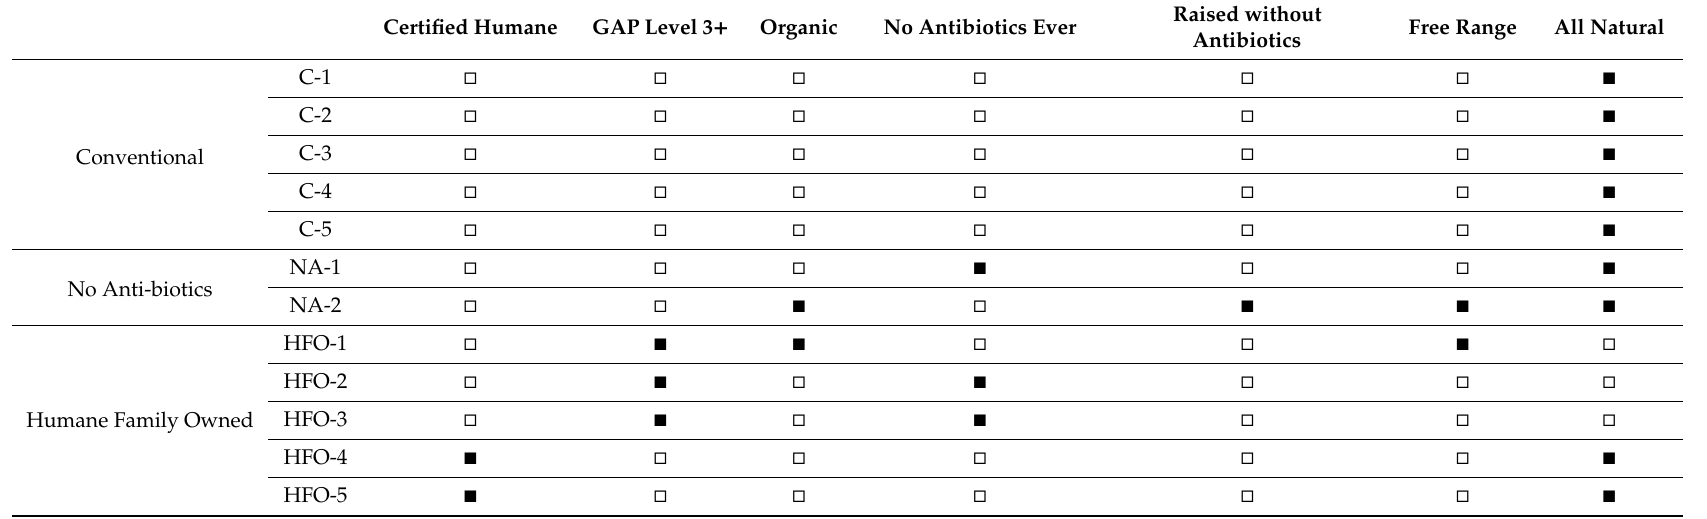
Table 2. Package labeling descriptions of antibiotic use and humane standards on the retail broiler chicken in this study 1 . Certified Humane GAP Level 3 + Organic No Antibiotics Ever